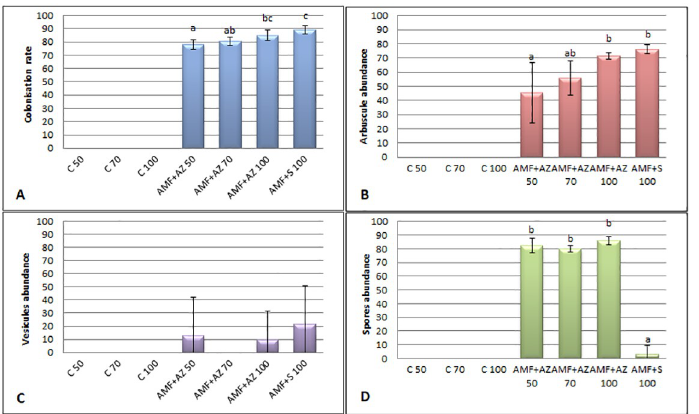
Fig 2. Effects of soil microorganisms application mycorrhization parameters of tomato roots: Colonization rate (A), arbuscule abundance (B), vesicules abundance (C), and spores abundance (D). Means followed by different letters are significantly different at P � 0.05, with comparisons performed by Fisher’s LSD test, only for mycorrhized objects. C 50—peat:sand ratio 50:50 (v:v) without inoculation; C 70 –peat:sand ratio 70:30 (v:v) without inoculation; C 100 –peat:sand ratio 100:0 (v:v) without inoculation; AMF +AZ 50 –peat:sand ratio 50:50 (v:v) inoculated with arbuscular mycorrhizal fungi (AMF) and Azospirillum brasilense (AZ), AMF + AZ 70 –peat:sand ratio 70:30 (v:v) inoculated with AMF and AZ, AMF + AZ 100 –peat:sand ratio 100:0 (v:v) inoculated with AMF and AZ; AMF + S– 100 peat:sand ratio 100:0 (v:v) inoculated with AMF and Saccharothrix tamanrassetensis (S).